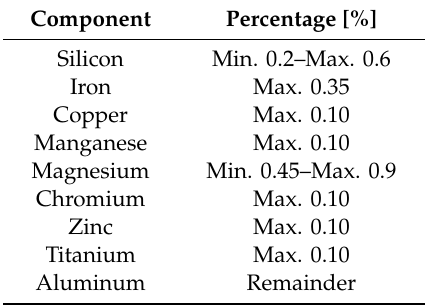
Table 1. The chemical composition of aluminum alloy 6063-T4.